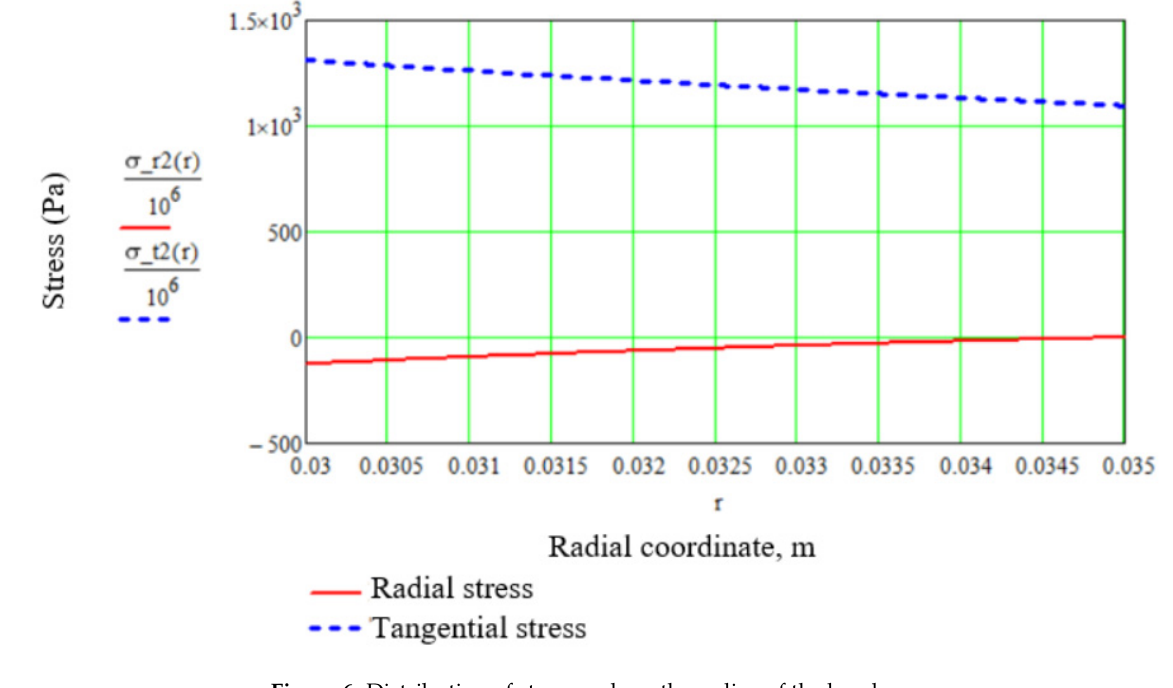
Figure 6. Distribution of stresses along the radius of the bandage.